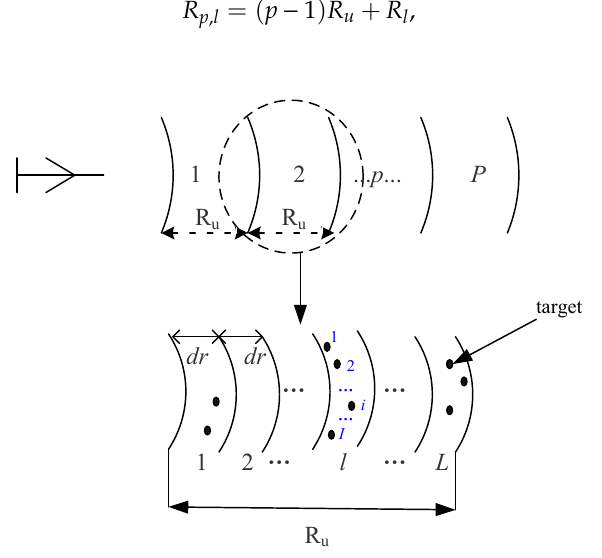
Figure 3. Division of range region.